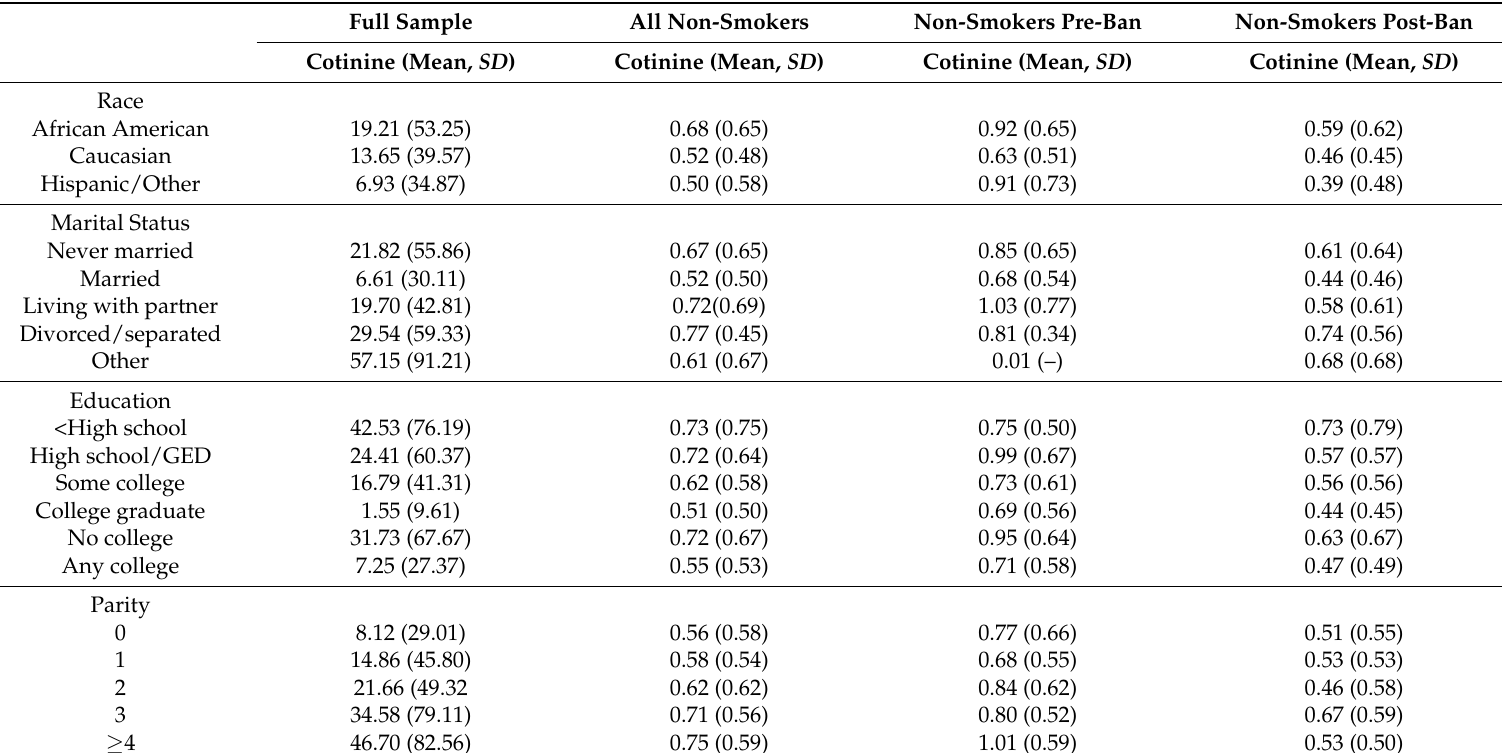
Table 2. Cotinine values for full sample, non-smokers, and non-smokers before and after the 2010 smoking ban. Full